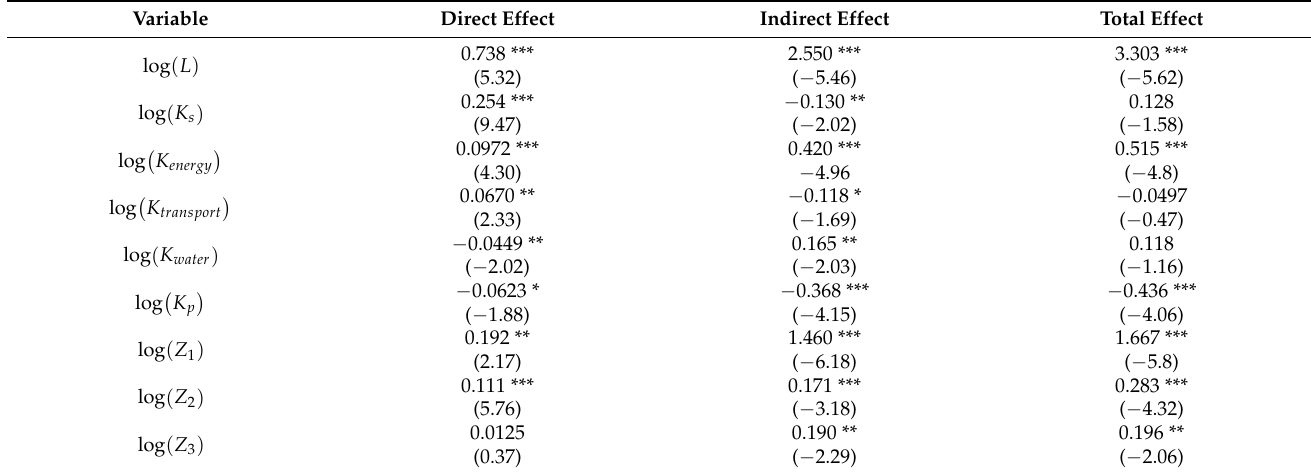
Table 6. Decomposition of spatial effects of various influencing